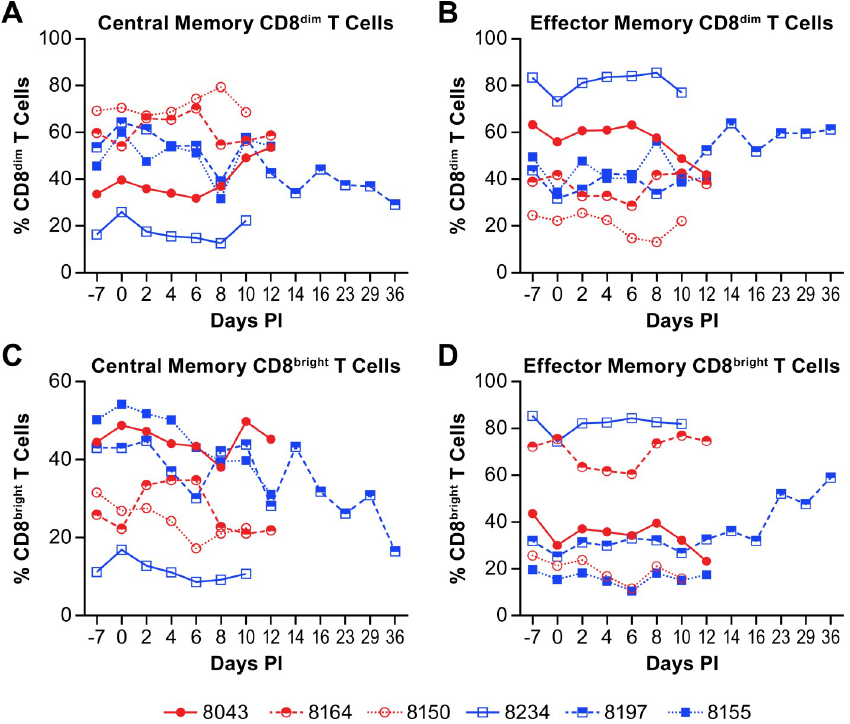
Fig 7. Changes in CD8+ memory T cell populations in animals infected with NiV. Plots show changes in the percent of CD8 dim central (A) and effector (B) memory populations in the total population of CD8 dim T cells and CD8 bright central (C) and effector (D) memory populations in the total population of CD8 bright T cells from individual animals infected with NiV. Red circles indicate the low dose group and blue squares indicate the high dose group. The cell surface markers for defining individual populations is provided in S3